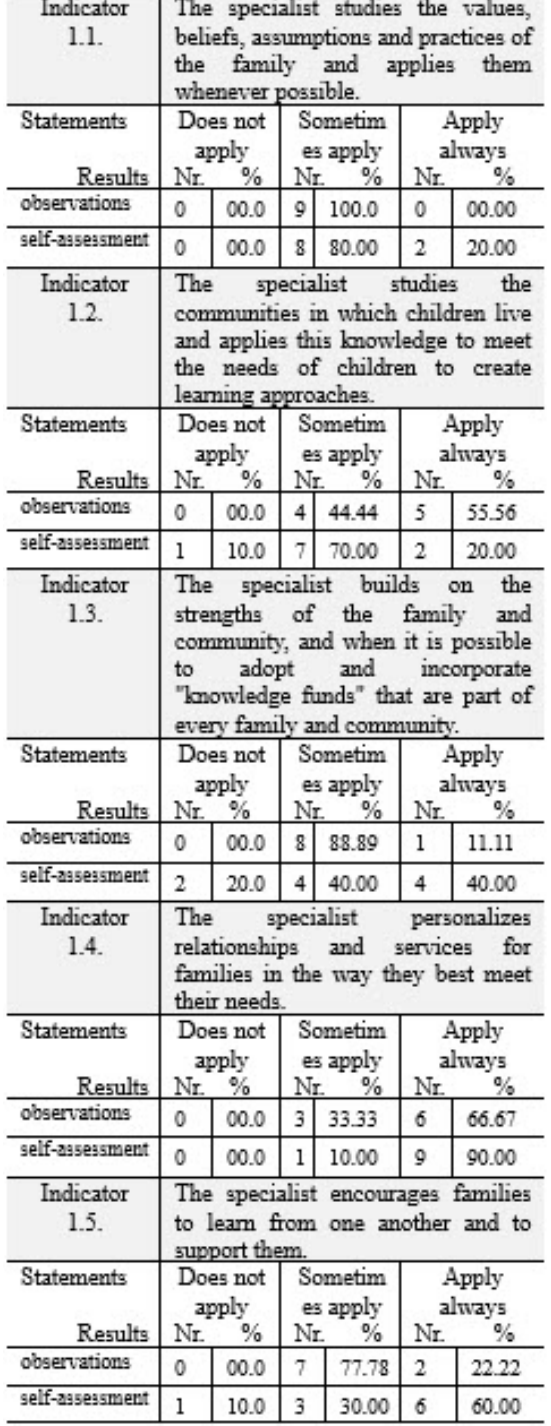
Table 6. Principle 1: Knowing and re - specting families and communities affirms their relationship with them and between them.